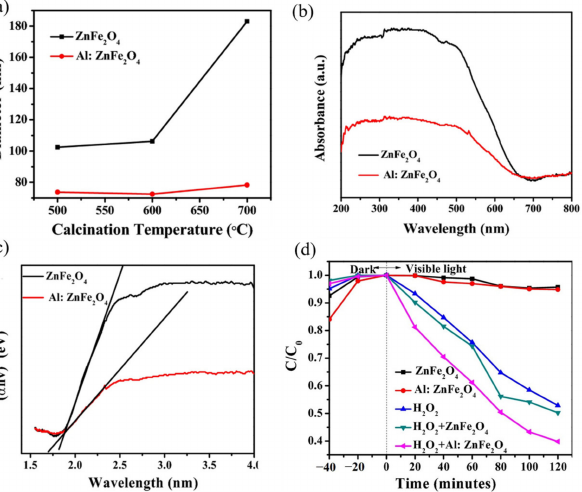
Figure 8. The ZnFe 2 O 4 nanofibers and Al-doped ZnFe 2 O 4 nanofibers: ( a ) plots of fiber diameters vs. calcination temperature; ( b ) UV-Vis DRS; ( c ) Tauc’s plots of calcined at 600 ◦ C; ( d ) photocatalytic degradation rates of RhB by the pure and Al-doped ZnFe 2 O 4 and their photo-Fenton process, with an H 2 O 2 oxidant [95] (reprinted with permission from [95] Musa et al., 2022).